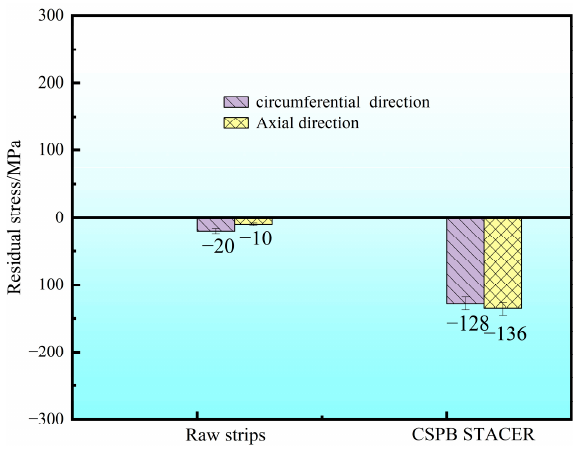
Figure 9. The residual stress results of raw strips and CSPB STACER using sin 2 Ψ